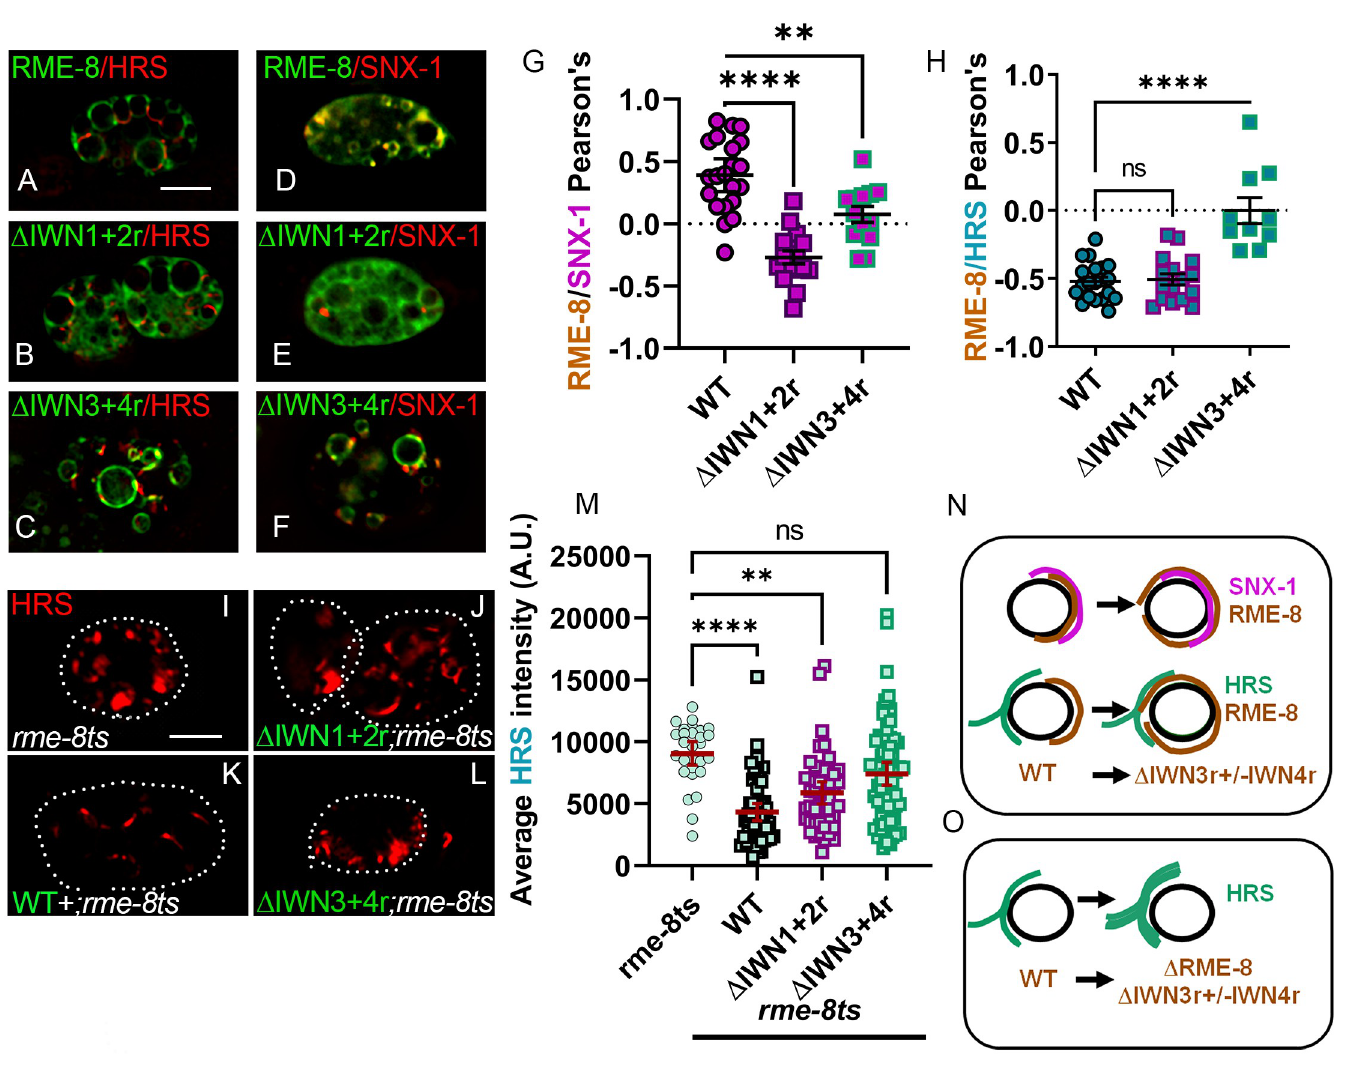
Fig 3. RME-8 C-terminal IWN3+4 regions mediate its recycling versus degradative domain segregation. Both N-terminal IWN1+2 and C-terminal IWN3+4 regions are important for HRS (HGRS-1) uncoating activity. (A-C) Micrograph of pCUP-4::GFP::RME-8 wild-type , N-terminal, and C-terminal truncations co-expressed with tagRFP::HRS (HGRS-1) in coelomocytes of wild-type animals. (D-F) Micrograph of pCUP-4::GFP::RME-8 wild-type , N-terminal, and C-terminal truncations co-expressed with tagRFP::SNX-1 in coelomocytes of wild-type animals. (G) Quantification of colocalization of pCUP-4::GFP::RME-8 wild-type and truncations indicated in Fig 2 with tagRFP::SNX-1 in coelomocytes of wild-type animals. (H) Quantification of colocalization of GFP::RME-8 wild-type and truncations with tagRFP::HRS(HGRS-1) in wild- type animals. (I-L) Micrograph of TagRFP::HRS(HGRS-1) in rme-8ts animals expressing N-terminal IWN1+2 and C-terminal IWN3+/-4 truncations (M) Quantification of tagRFP-HRS(HGRS-1) average intensity in rme-8ts animals expressing pCUP-4::GFP::RME-8+, N-terminal, or C-terminal truncations. (N) Illustration of the microdomain segregation that is disrupted when IWN3 and IWN4 regions are deleted in RME-8. (O) Illustration of the accumulation of HRS (HGRS-1) that occurs in the absence of RME-8, and N-terminal IWN1+2 and C-terminal IWN3+/-4 regions. Each data point is an individual worm, error bars indicate Mean with 95% CI, ANOVA statistical analysis done in Prism with p < 0.5 = � , p < 0.01 = �� , p < 0.001 = ��� , p < 0.0001 = ���� . Scale bars are 5 microns in whole coelomocyte images.